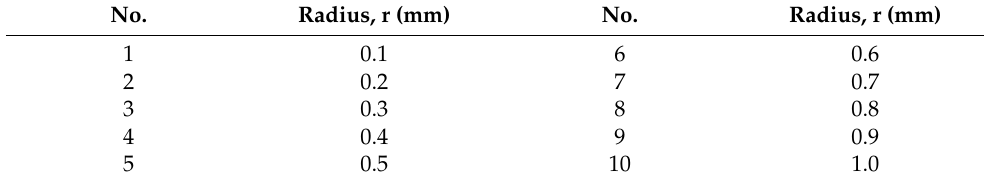
Table 3. Radius parameters of blood vessels